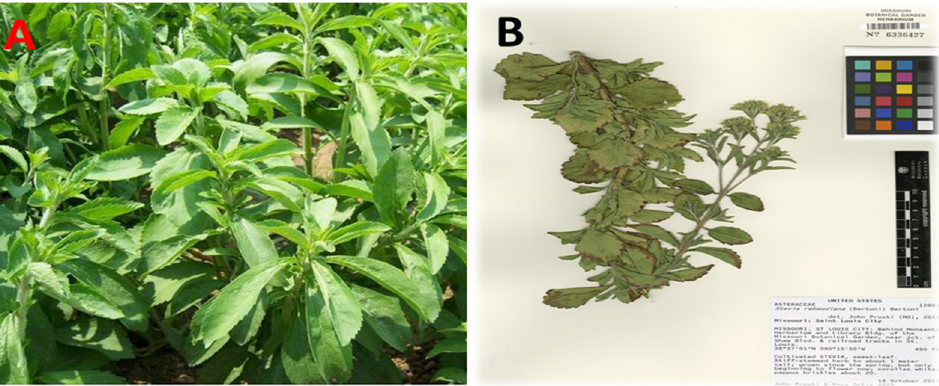
Figure 1. ( A ) S. rebaudiana (Bertoni) Bertoni Asteraceae leaves; ( B ) Botanical Voucher Specimen, ↑ MOBOT, Tropicos.org (http://www.tropicos.org/Image/100229514, 1 March 2022).